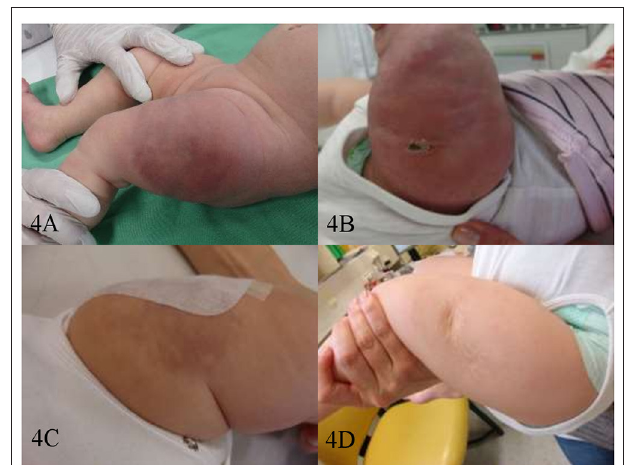
FIGURE 4 | Patient #15. Kaposiform hemangioendothelioma of the left thigh before therapy (A) on day 20 of sirolimus monotherapy—after 1st biopsy (B) on day 14 of sirolimus/vincristine combination therapy—after the 2nd biopsy (C) and after 1 year of therapy- − 6 months of sirolimus/vincristine, and 6 months of consecutive sirolimus monotherapy (D)